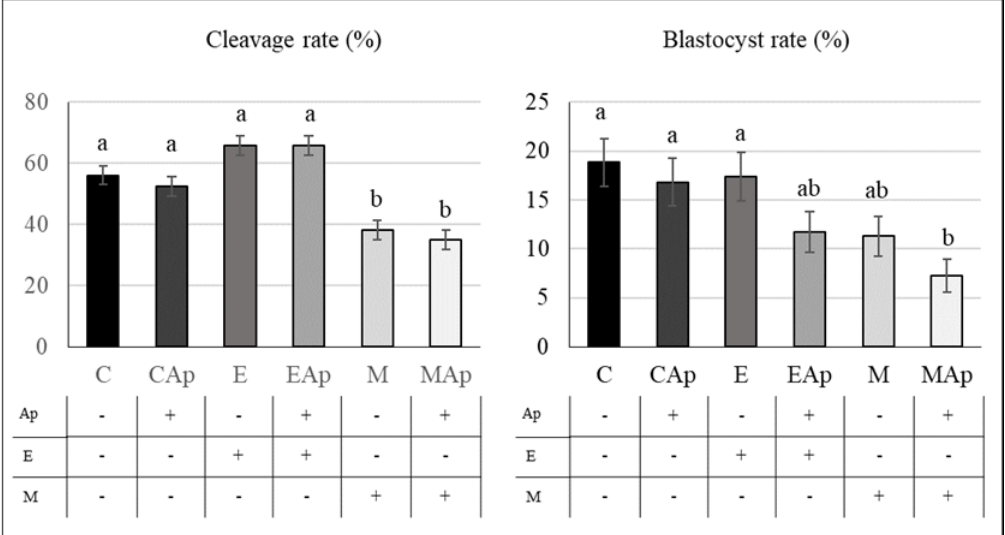
Figure 6. Effect of aphidicolin and method of CRISPR/Cas9 delivery on porcine embryo development. Figure shows cleavage and blastocyst rate of oocytes incubated without (C) or with 0.5 µ M aphidicolin (Ap), electroporated and incubated without (E) or with 0.5 µ M aphidicolin (EAp) and microinjected and incubated without (M) or with 0.5 µ M aphidicolin (MAp). a,b Values with different superscripts are significantly different ( p < 0.05).